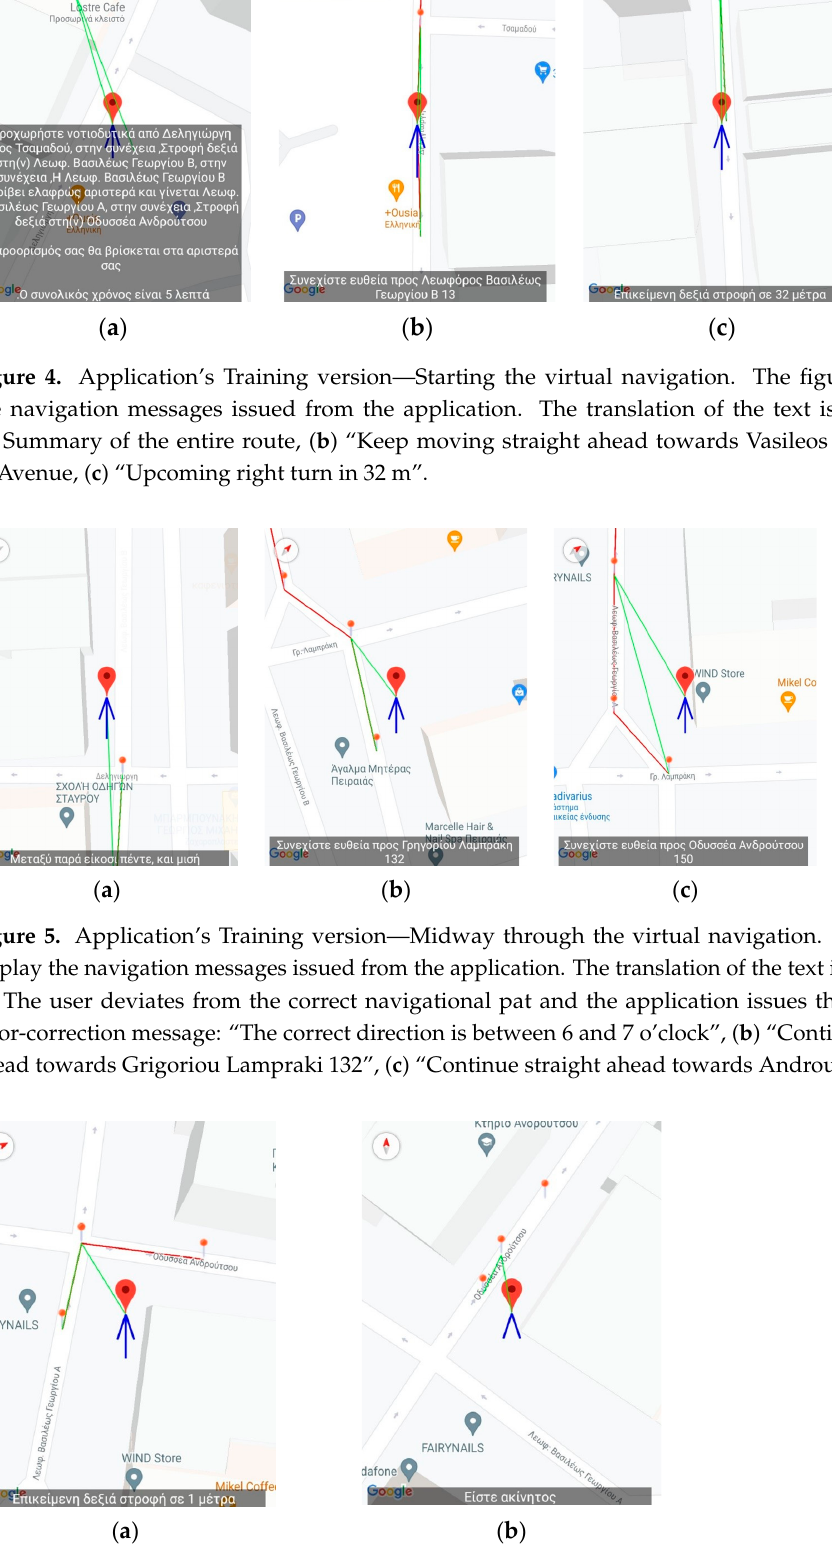
Figure 6. Application’s Training version—End of virtual navigation. The figures display the navigation messages issued from the application. The translation of the text is as follows: ( a ) Turn right in 1 m”, ( b ) “You have reached your destination”.